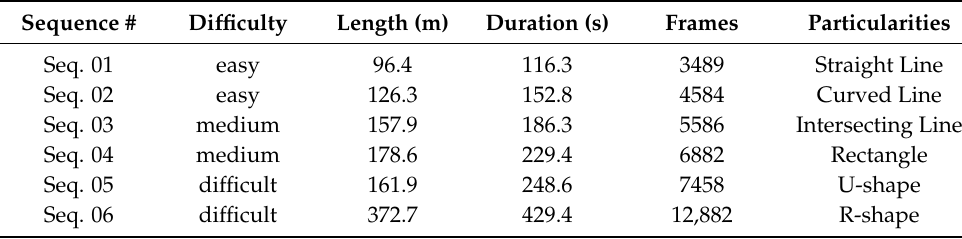
Table 2. Sequence